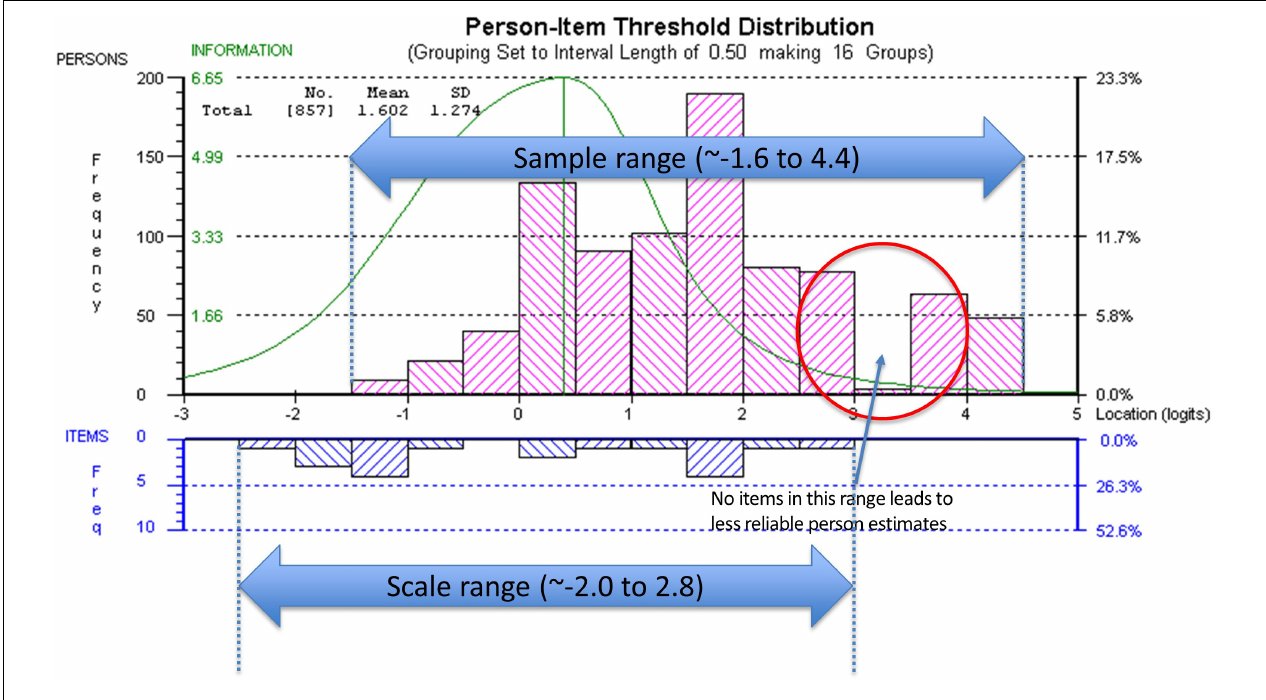
FIGURE 4 | Person-item threshold distribution map. TABLE 3 | Summary fit statistics for Starkstein’s Apathy Scale.